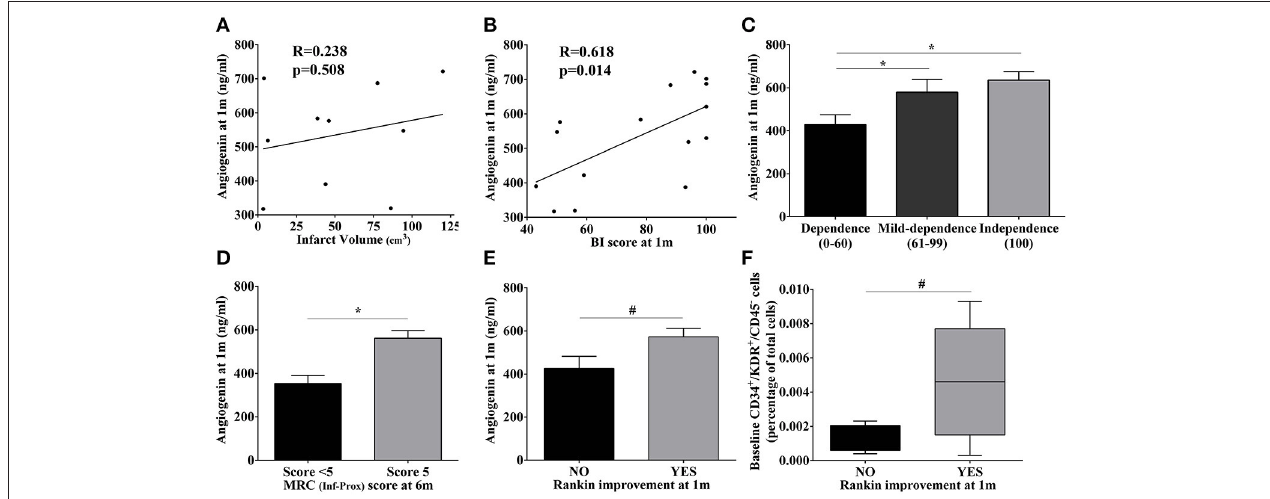
FIGURE 4 | Association of molecular and cellular markers with infarct volume and motor/functional scores in stroke patients. (A , B) Scatter plot showing the correlations of angiogenin levels at 1 month with infarct volume and the BI score, respectively. (C–E) Bar graphs showing angiogenin levels at 1 month with BI score categories, MRC scores, and Rankin improvement at different time points;* p < 0.05, # p < 0.1. (F) Bar graphs representing baseline CD34 + /KDR + /CD45 − cells according to the Rankin improvement at 1 month. Bar graphs are represented as the mean ± SEM, and box plots are represented as the median (IQR). BI, Barthel index; m, month; MRC, Medical Research Council; Inf-Prox,